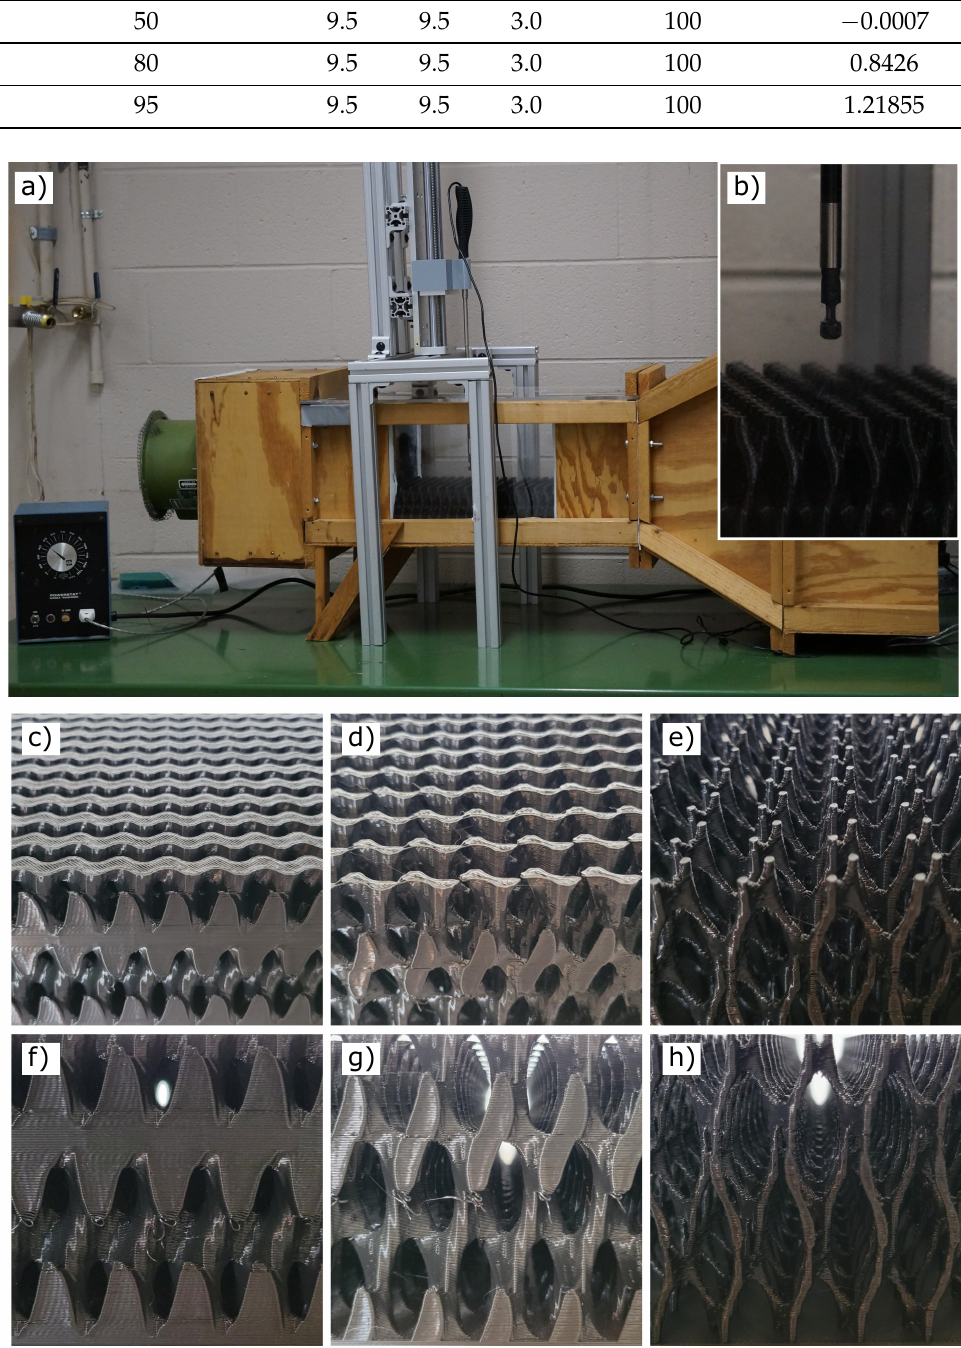
Figure 2. ( a ) Wind tunnel setup and ( b ) a close up view of the test section and the sensor. ( c – h ) The 3D-printed models observed from the top (the top row) and side (the bottom row). ( c , f ) At 50% porosity; ( d , g ) 80% porosity; ( e , h ) 95%